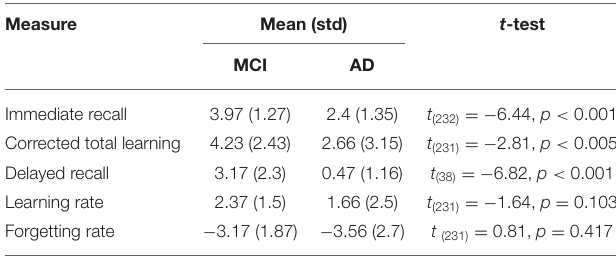
TABLE 1 | The number of words recalled per group and group comparisons in the standard measures used in clinical